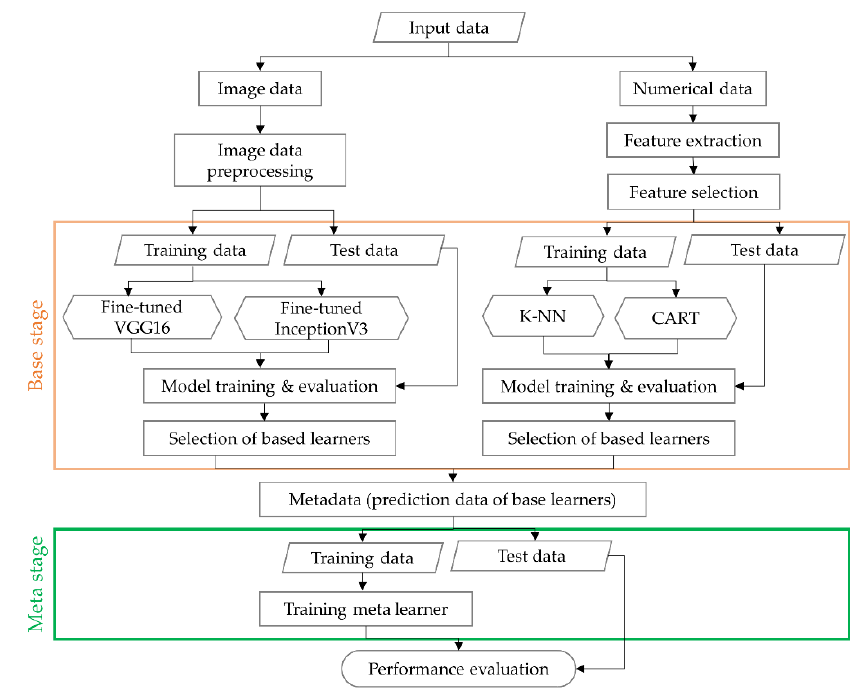
Figure 10. Scheme showing the proposed stacking ensemble model.